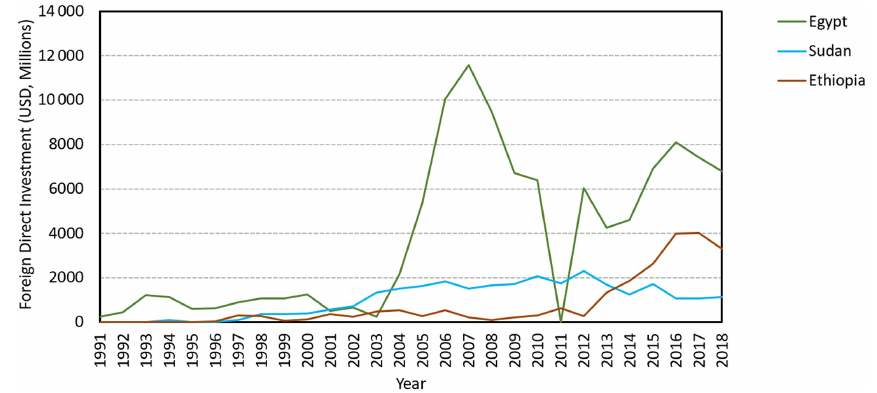
Figure 5. The foreign direct investments from 1991 to 2018 in millions of US dollars (USD) per year (Food and Agriculture Organization Data, 2020a) in Egypt, Sudan, and